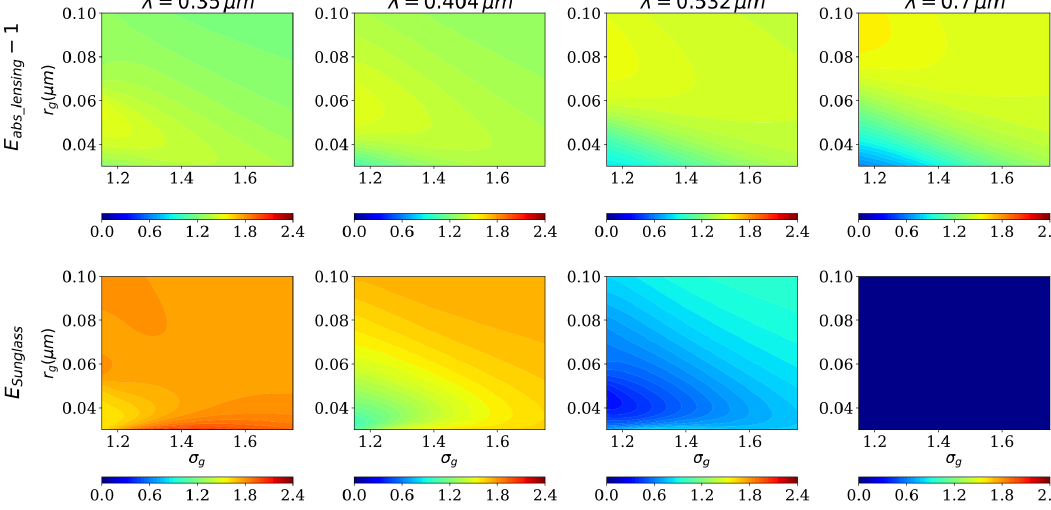
Figure 7. Similar to Fig. 6, but for E abs_lensing and E Sunglass